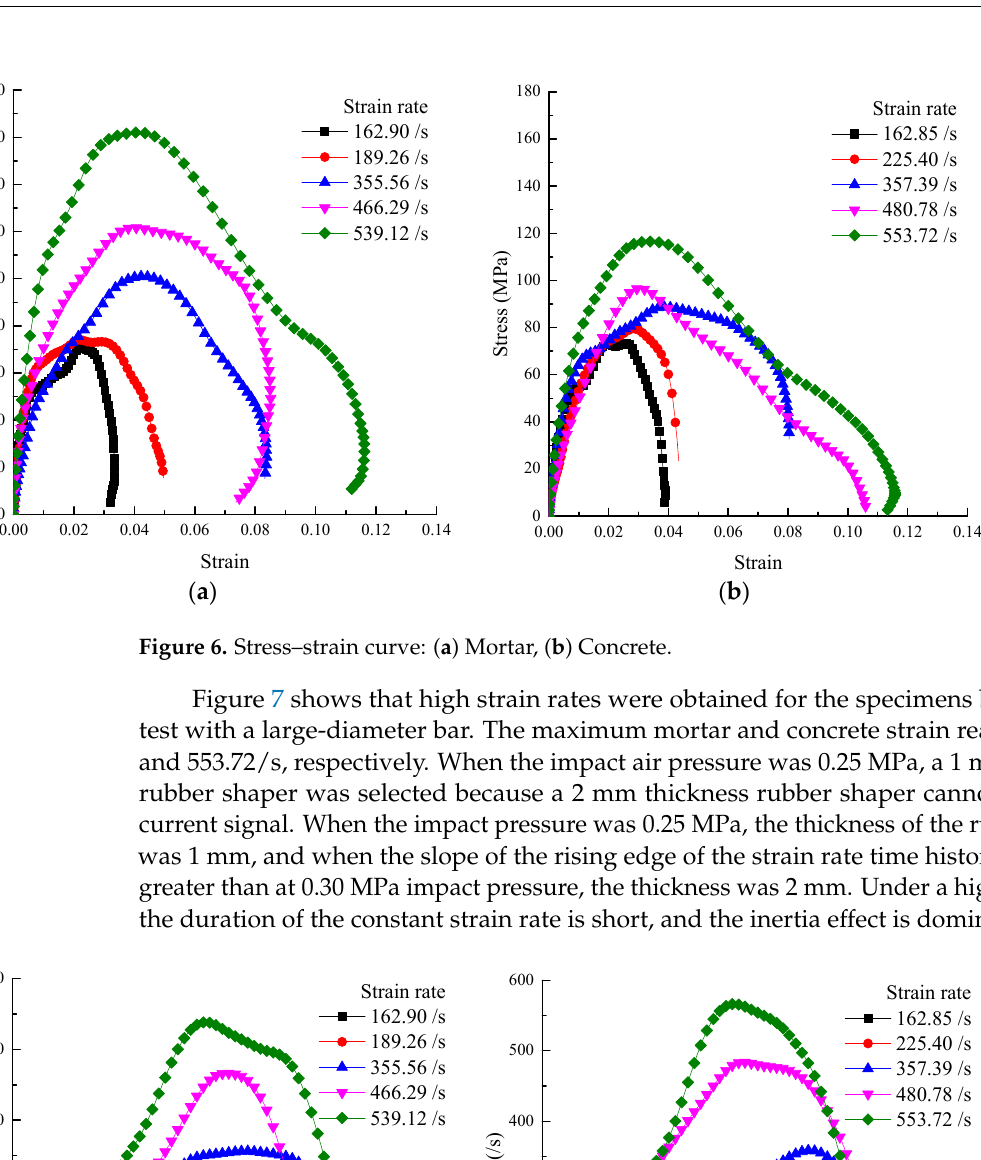
Figure 8. Variation of DIF with logarithm of strain rate.